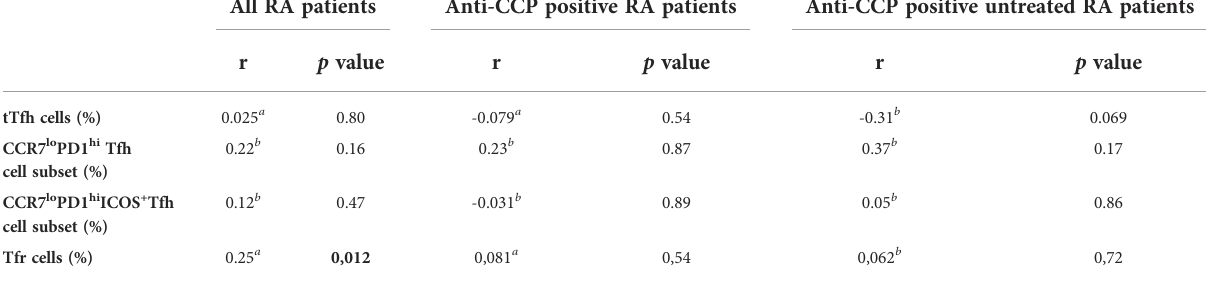
TABLE 2 Correlation between anti-Cyclic Citrullinated Peptide antibody levels and different T follicular cell populations. All RA